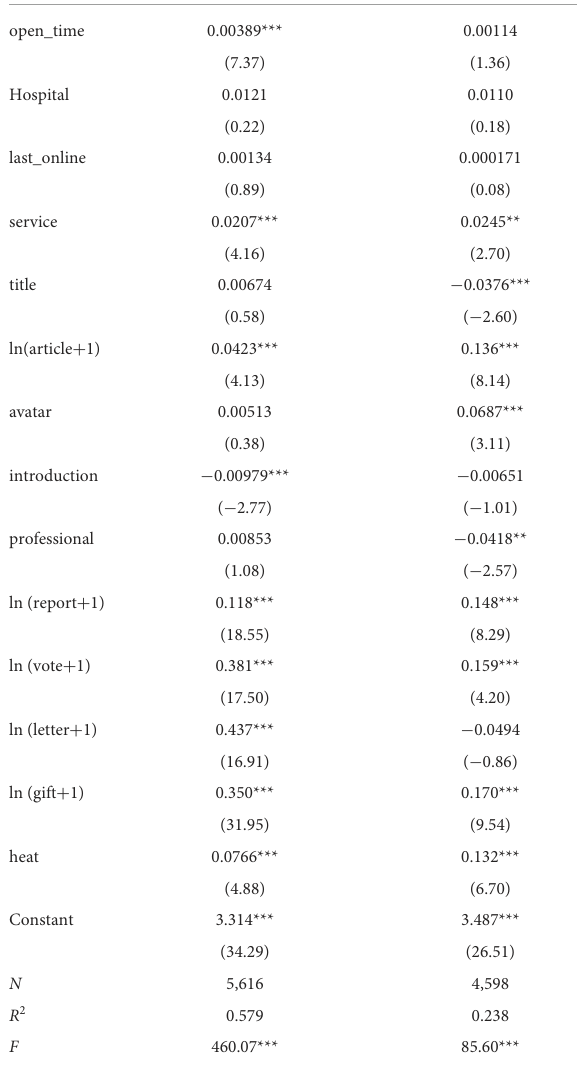
TABLE 5 Regression results of